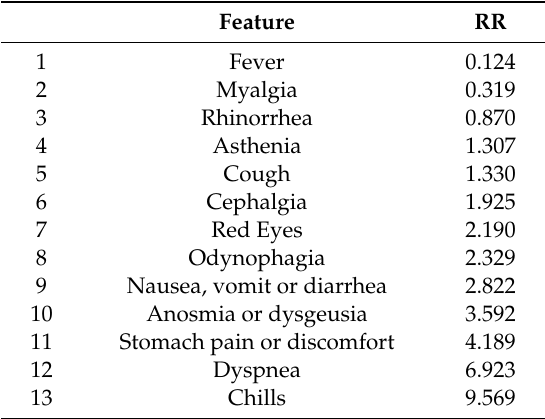
Table 5. RR of the full set of